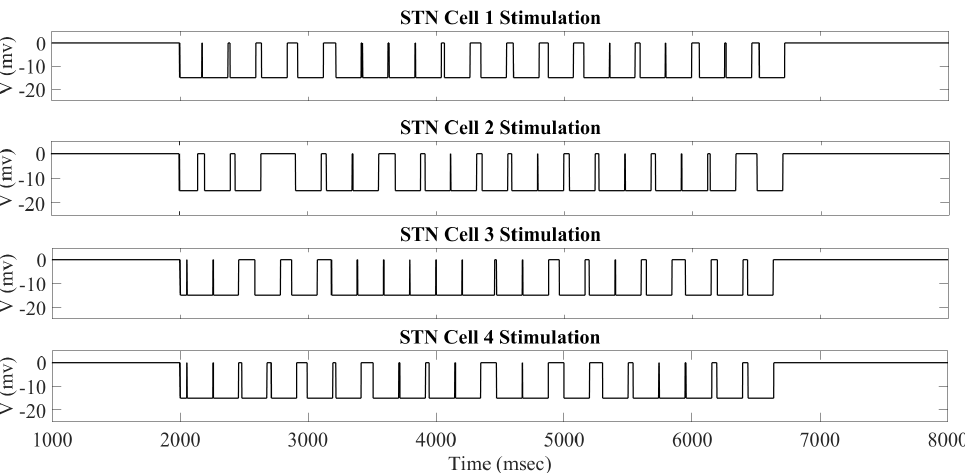
Figure 1. acDBS delivered to STN Cells 1–4 during the time window of 2000 to 7000 ms. Note that the top part of the curve represents the time when the stimulation is turned off, while the bottom part of the curve is when the stimulation is turned